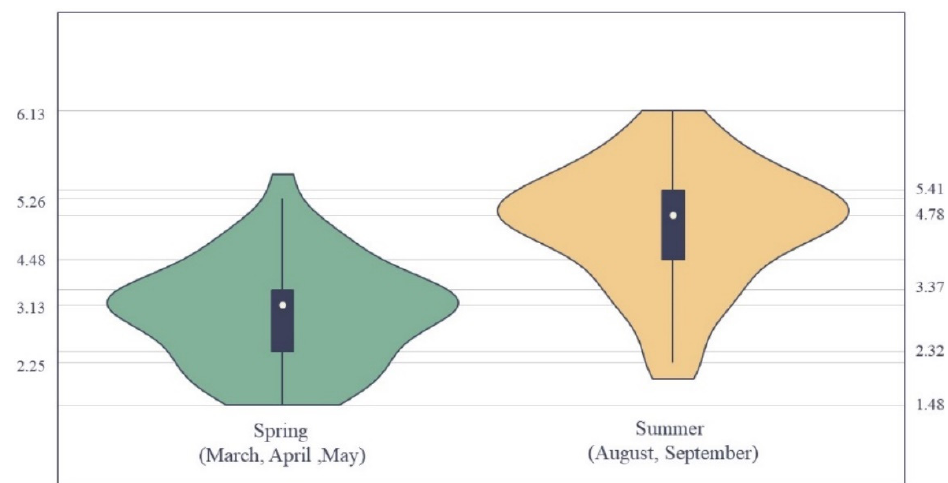
Figure 2. Violin plot of lg (Catch) distribution of A. thazard for spring and summer.